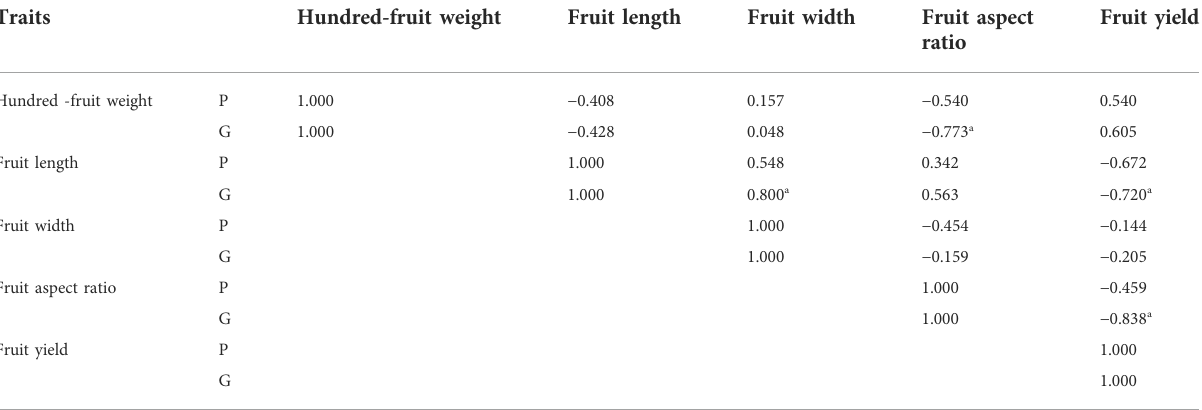
Fruit yield ratio